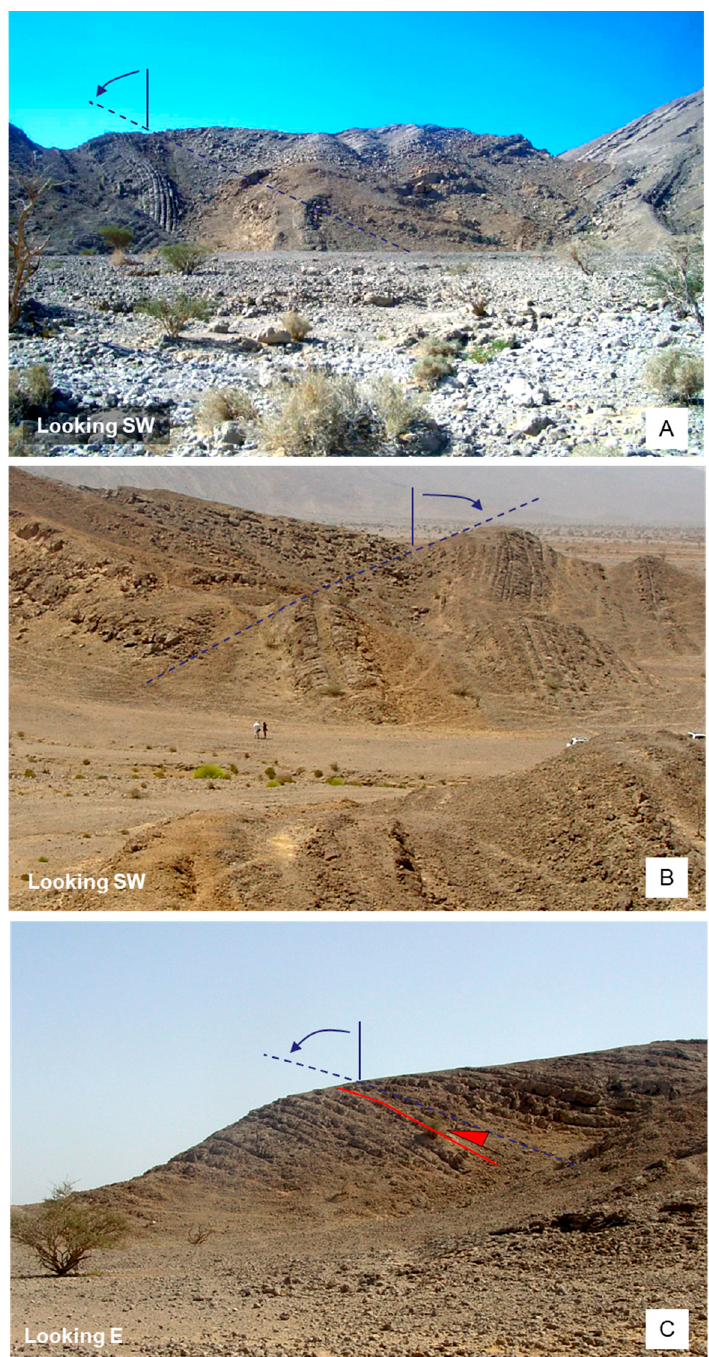
Figure 9. Examples of the flanking folds in ( A ) Jebel Salakh E and in ( B ) and ( C ) Jebel Hinaydil that verge away from the main fold axes. The fold axes of the flanking folds are shown as dashed blue lines.